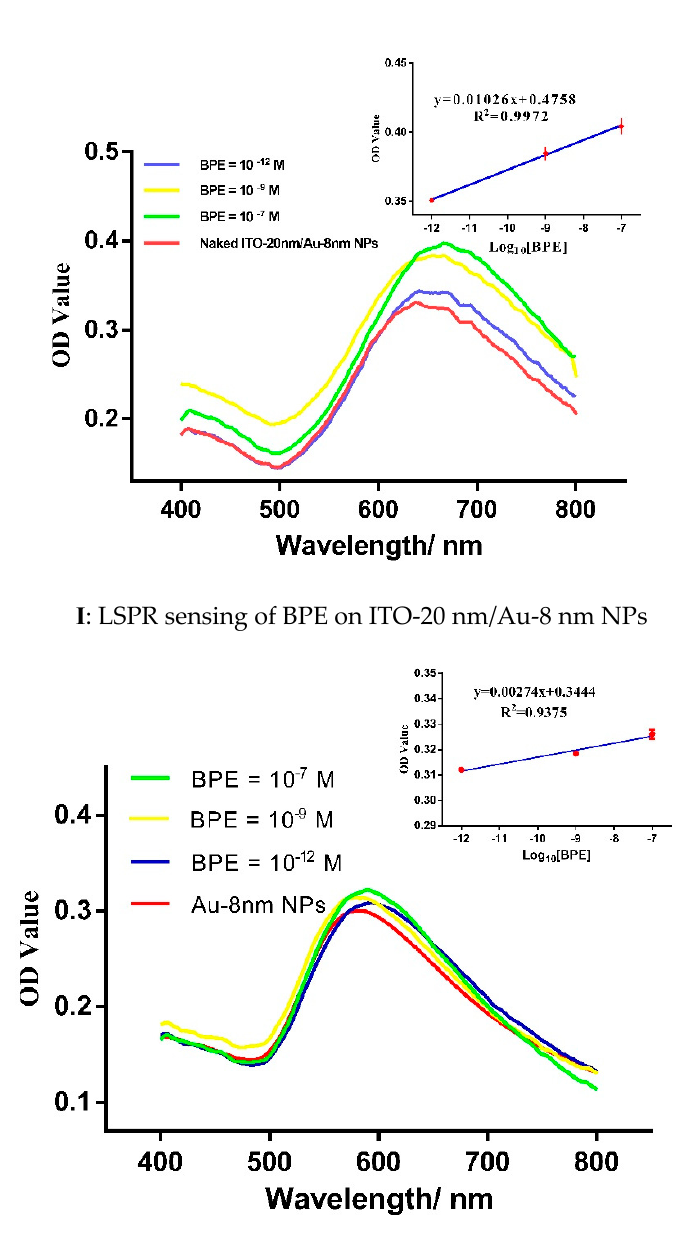
Figure 7. LSPR sensing of BPE traces on annealed ( I ) ITO-20 nm/Au-8 nm NPs and ( II ) Au-8 nm NPs formed on small- sized coverslips. The insets show the linear evolution of OD values for the LSPR tested concentrations on two types of nanostructured